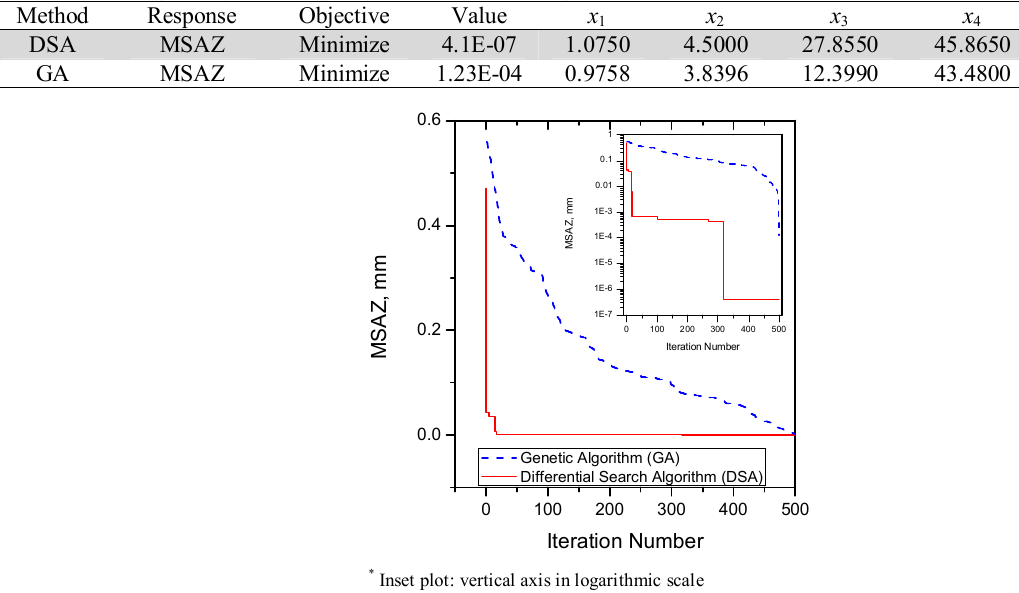
Results of single objective optimization for Example 3